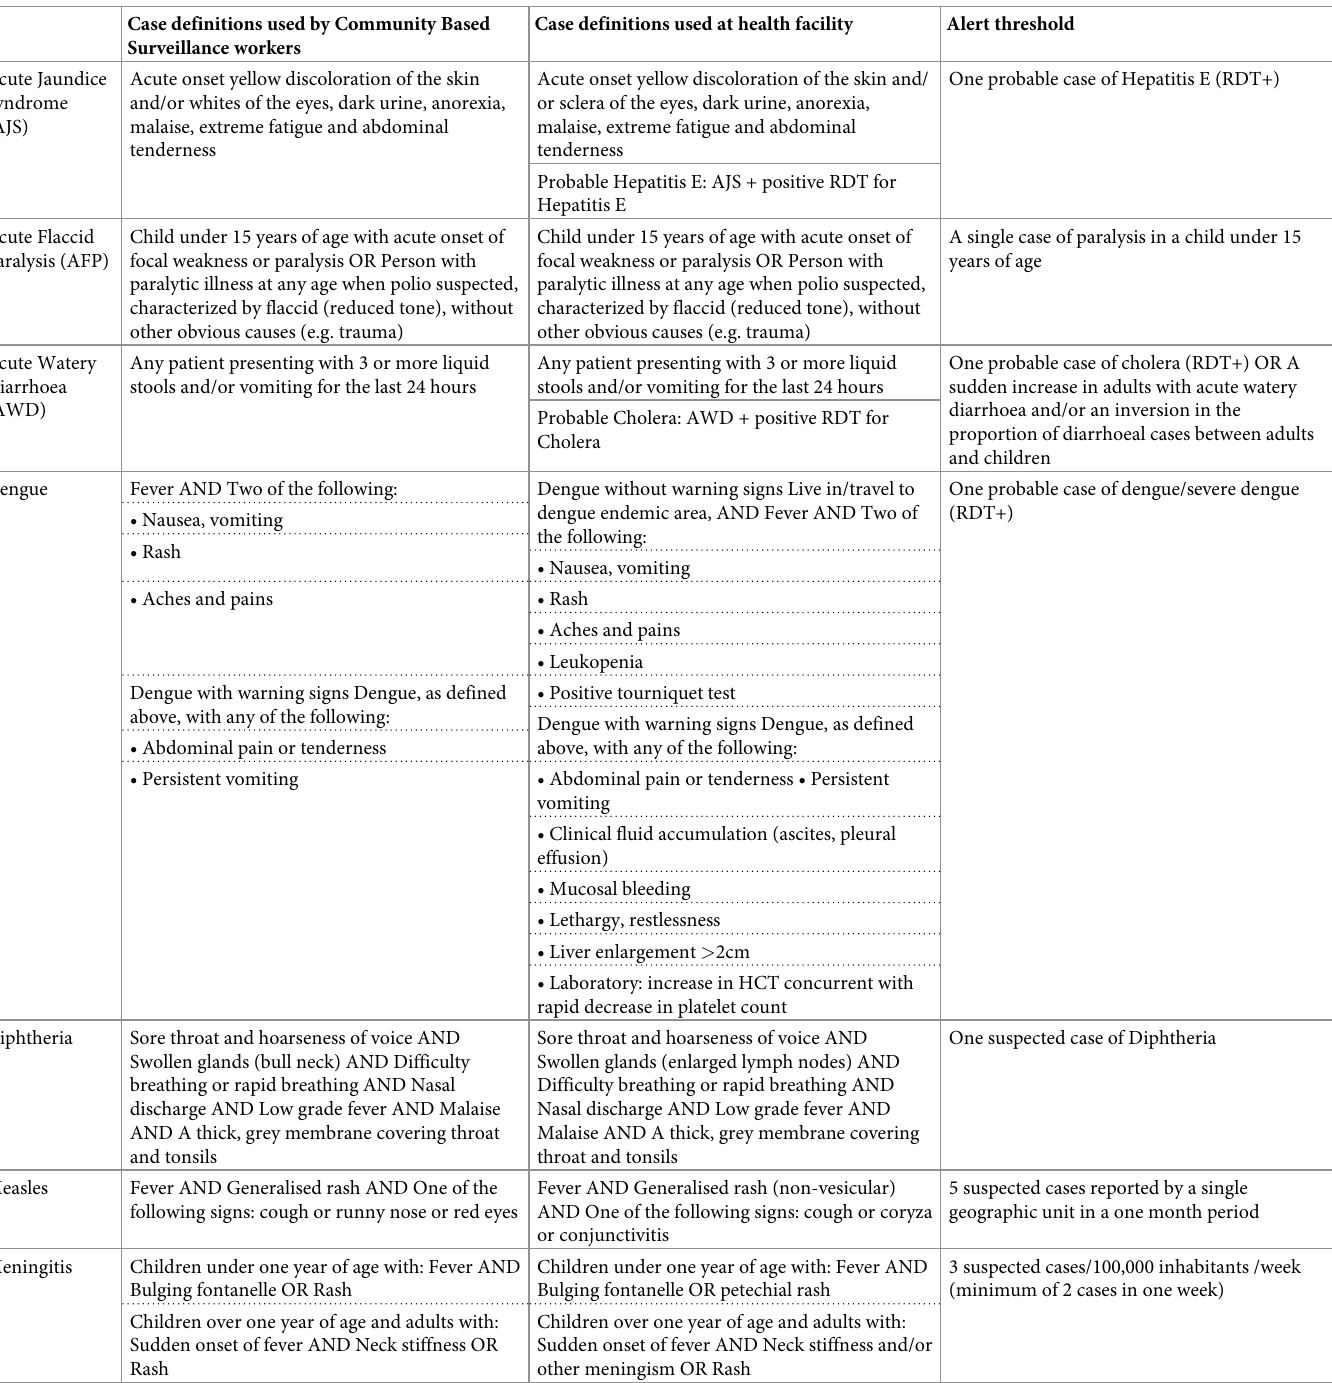
Table 1. CBS case definitions syndromes/diseases under surveillance by MSF in Cox’s Bazar, Bangladesh, week 20–44, 2019 [5]. Case definitions used by Community Based Surveillance